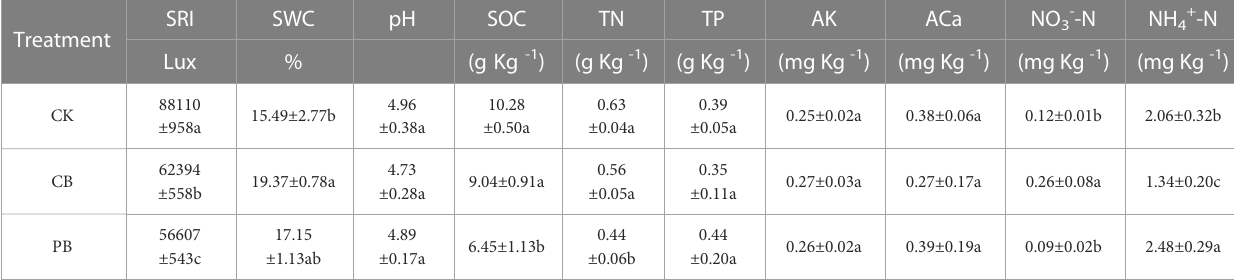
TABLE 1 Environmental factors properties among B. striata plantations.